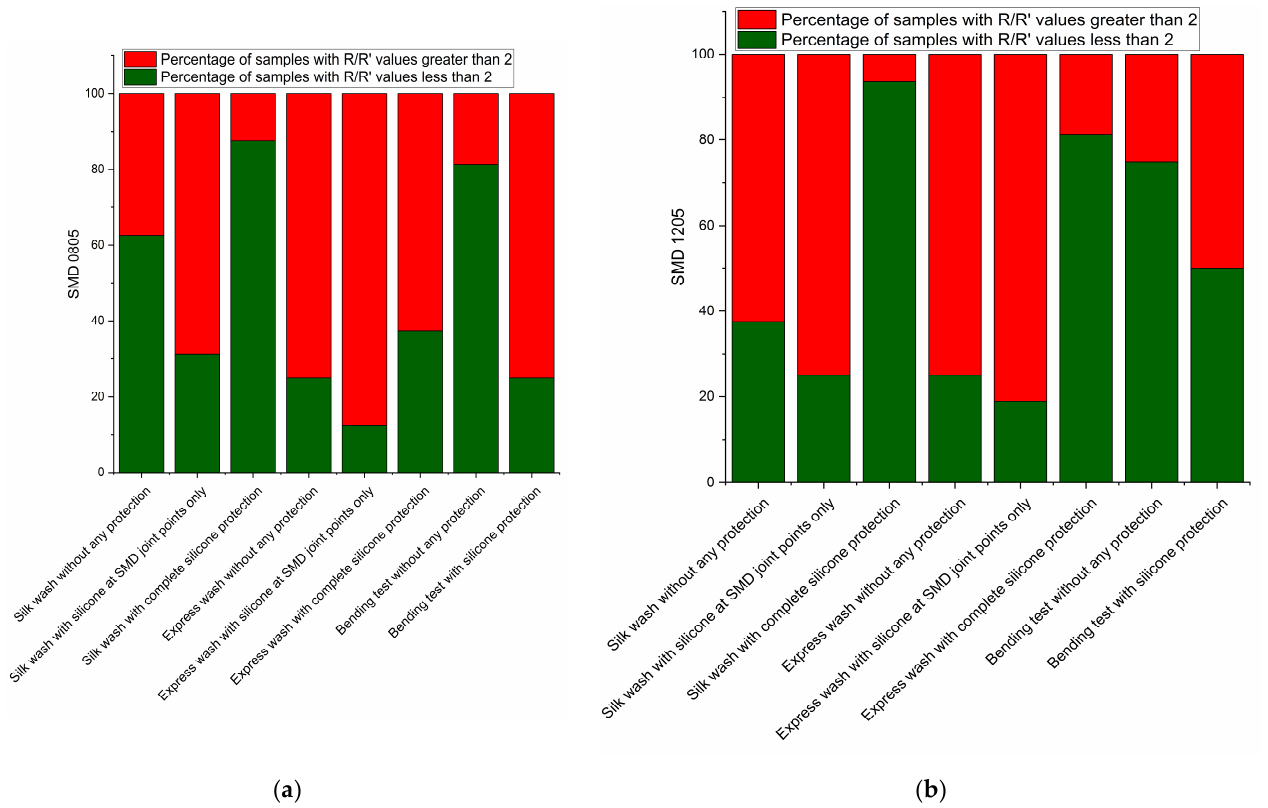
Figure 10. Percentage of samples with R’/R values above and below 2: ( a ) samples with SMD 0805; ( b ) samples with SMD 1205.